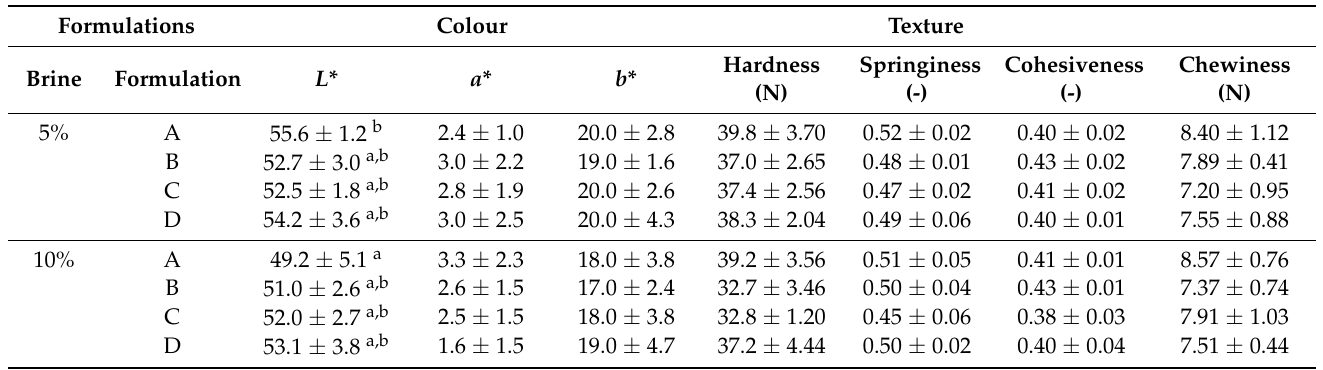
Table 3. Colour and texture properties of the smoked mackerel formulations.